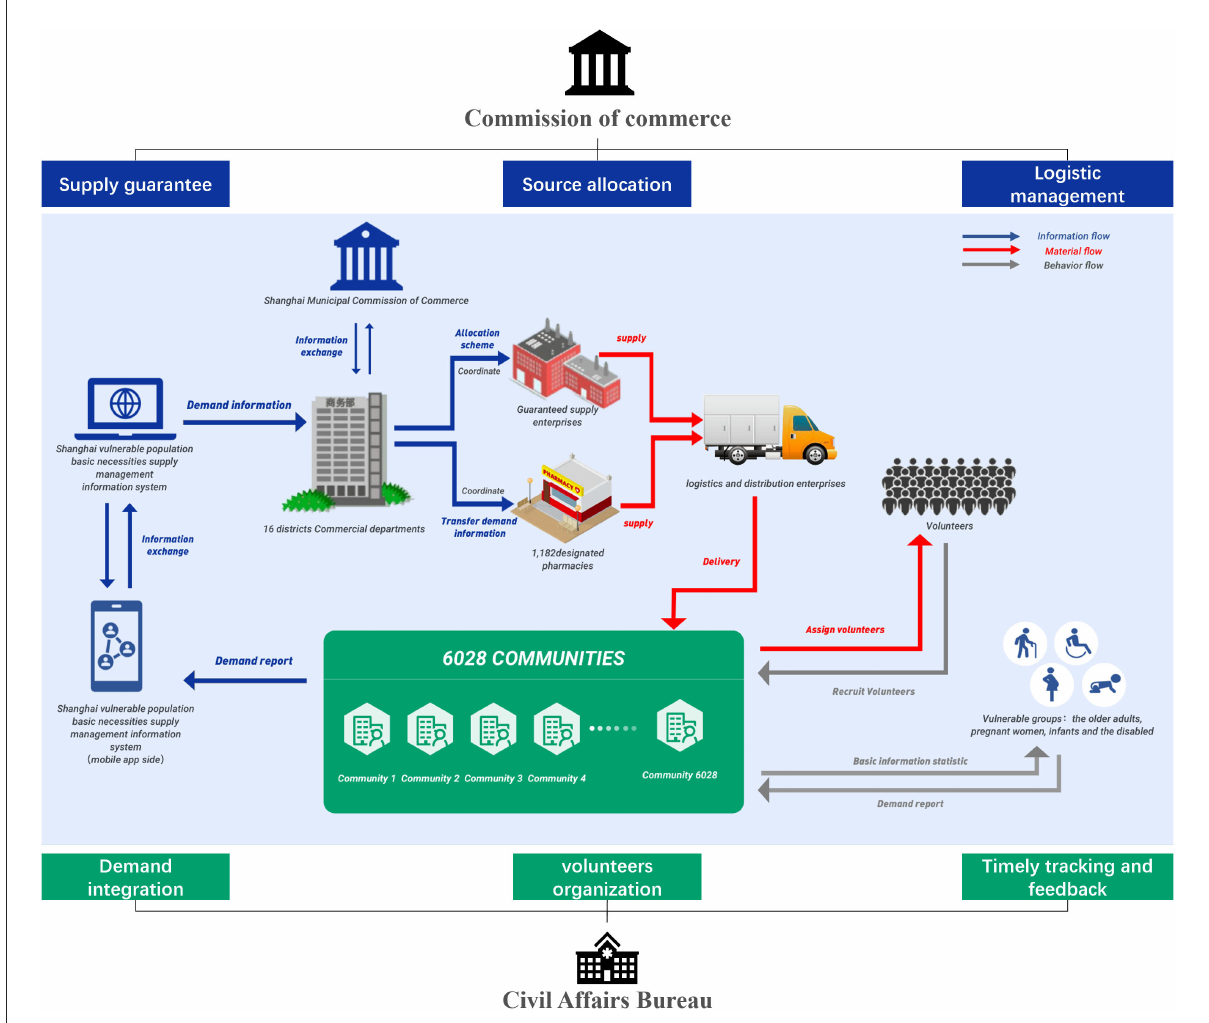
FIGURE1 The overview supply scheme of basic necessities for vulnerable populations in Shanghai during the Omicron